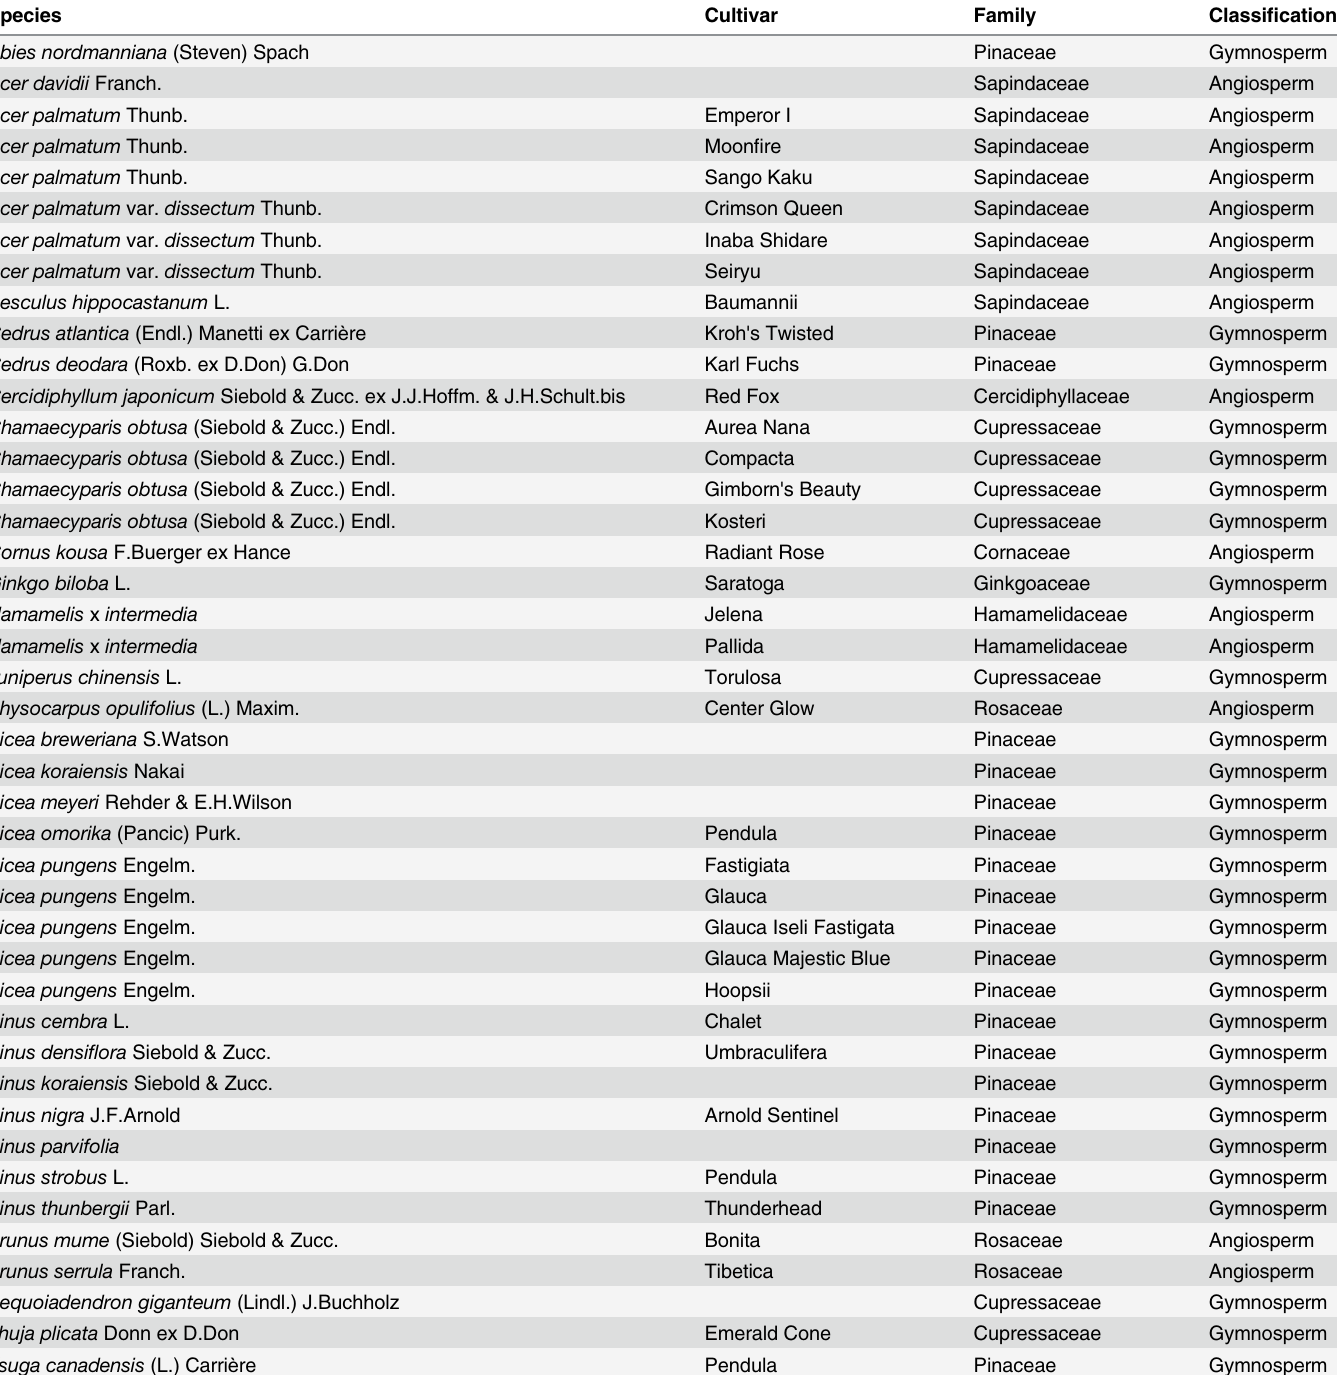
Table 3. Species and cultivars on which no Halyomorpha halys individuals of any life stage were observed